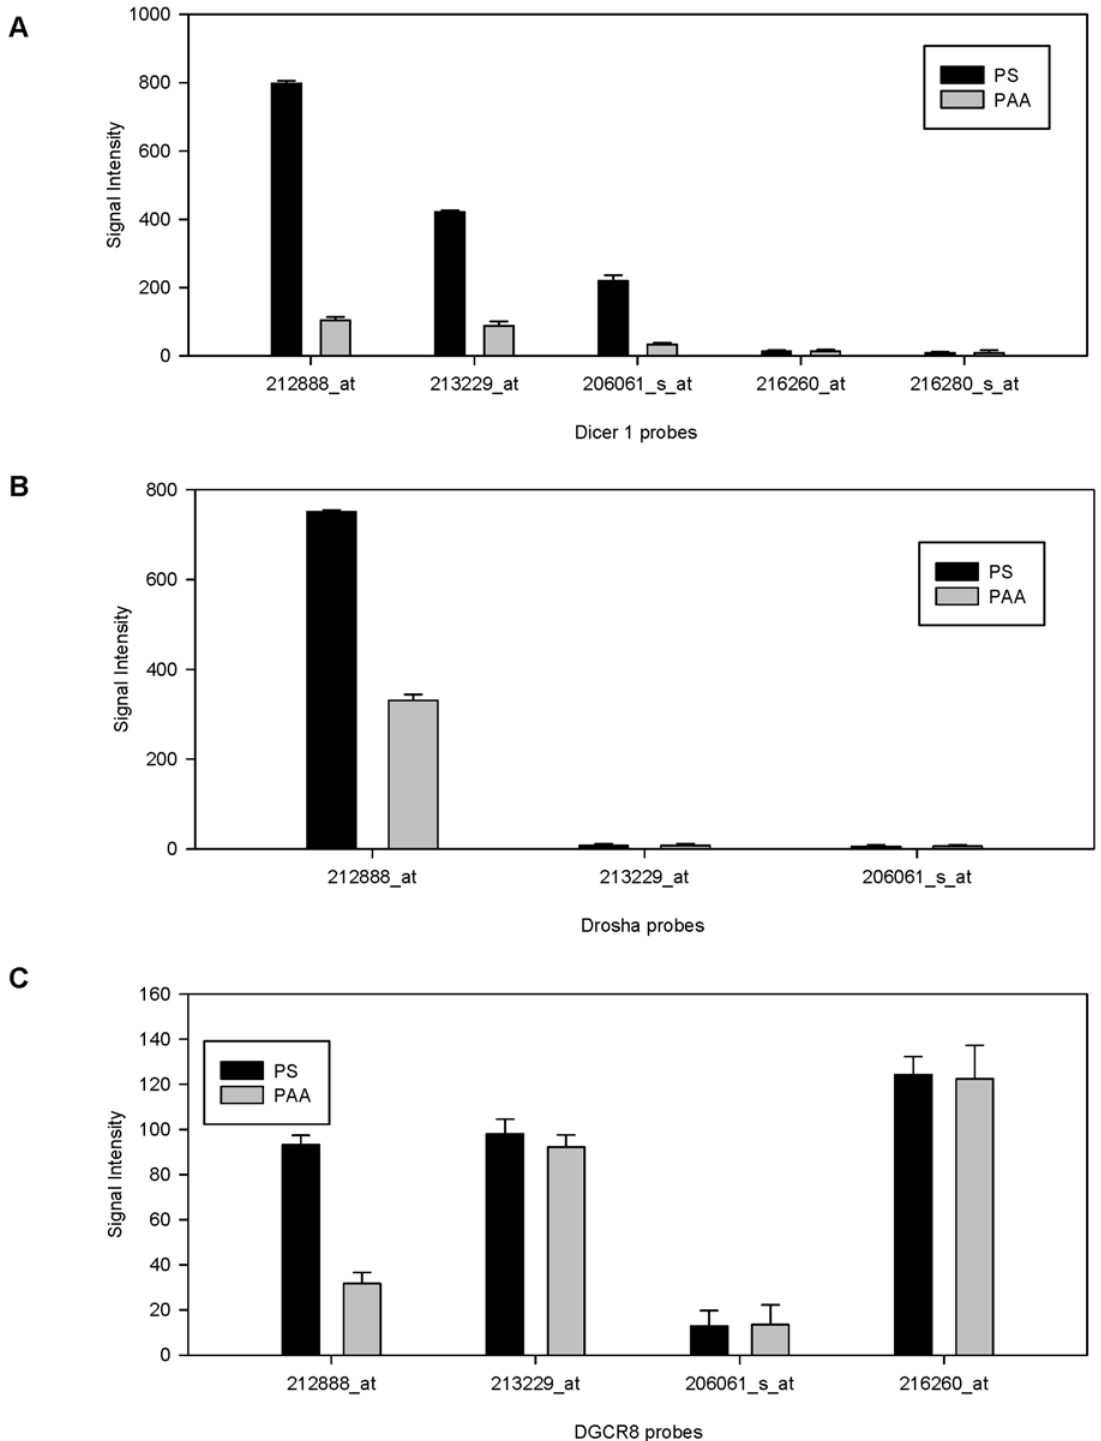
Fig 10. Downregulation of miRNA processing genes on PAA. Microarray signal intensities of miRNA processing enzymes were compared on PS and PAA. Error bars represent standard deviation.